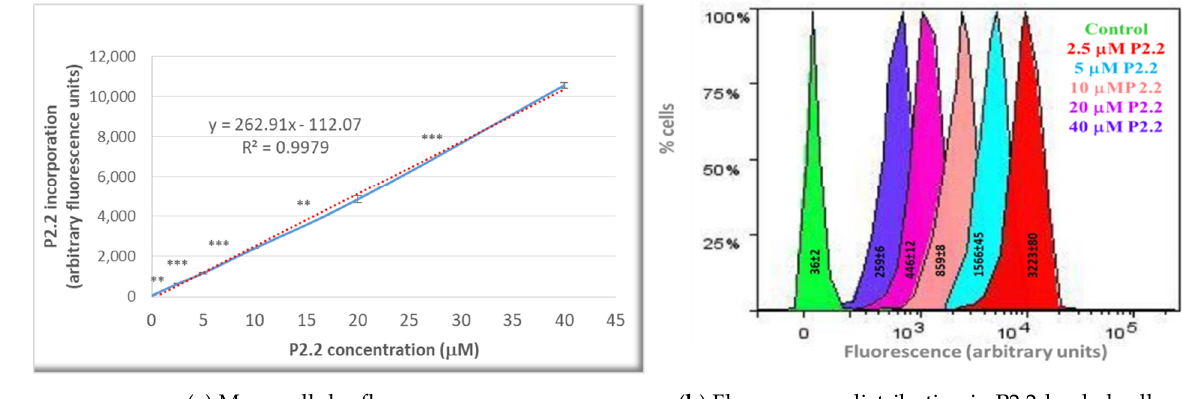
Figure 2. The uptake of the fluorescent P2.2 photosensitizer by HT29 tumor cells. Cells were incubated for 24 h with 2.5–40 µM P2.2. Intracellular P2.2 was evaluated by flow cytometry, based on the red P2.2 fluorescence. Fluorescence data, expressed in arbitrary units, and their median values in each sample were obtained with the BD FACSDiva software (Becton Dickinson). ( a ) Median cellular fluorescence. Data are presented as the mean value of the median fluorescence of each sample of the triplicate (mean ± SEM). Comparison between samples treated with consecutive P2.2 concentrations was performed using Student’s t -test considering unequal variances: ** p < 0.01, *** p < 0.001. ( b ) Fluorescence distribution in samples treated with various P2.2 concentrations. The represented SD values, obtained with the BD FACSDiva 6.1 software, are a measure of the fluorescence values spread around the mean value in a defined cellular population.